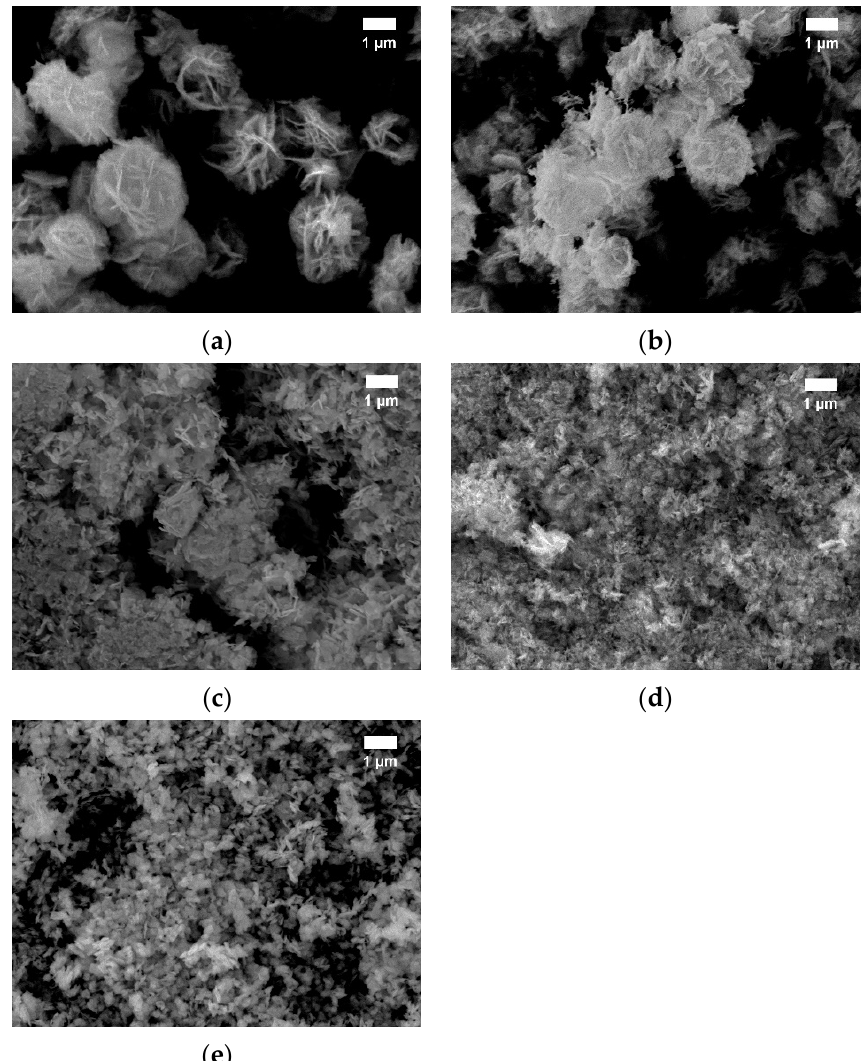
Figure 2. Layered perovskite Bi 2 WO 6 ( x = 1) has a 3D flower-like structure, consisting of